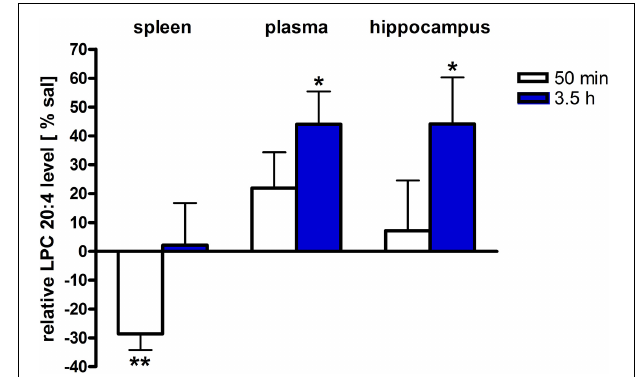
FIGURE 4 | LPC 20:4 levels of brain and periphery after PEA treatment. Relative LPC 20:4 concentrations (normalized to ml plasma/tissue weight) after PEA treatment as percentage of saline treated mice are shown and presented as mean value ± SEM. Relative lipid level for two different time points are depicted. Time specific changes in LPC 20:4 levels occur in spleen at 50 min while in plasma and hippocampus at 3.5 h after PEA treatment. Data were considered significant at a p -value < 0.05, e.g., ∗∗∗ p < 0.001, ∗∗ p = 0.001 to 0.01; ∗ p = 0.01 to